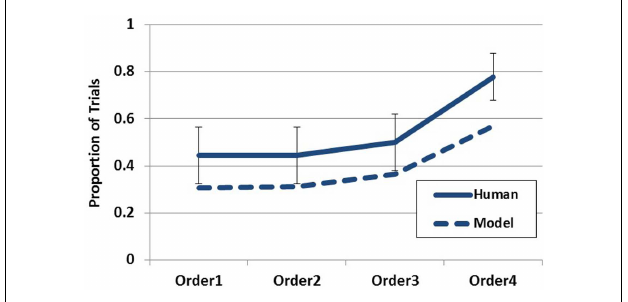
FIGURE 6 | Empirical data (solid line) and model data (dashed line) for Experiment 1 plotting the probability of reporting D1 (Metalytis) as most likely across order conditions. Error bars represent standard errors of the